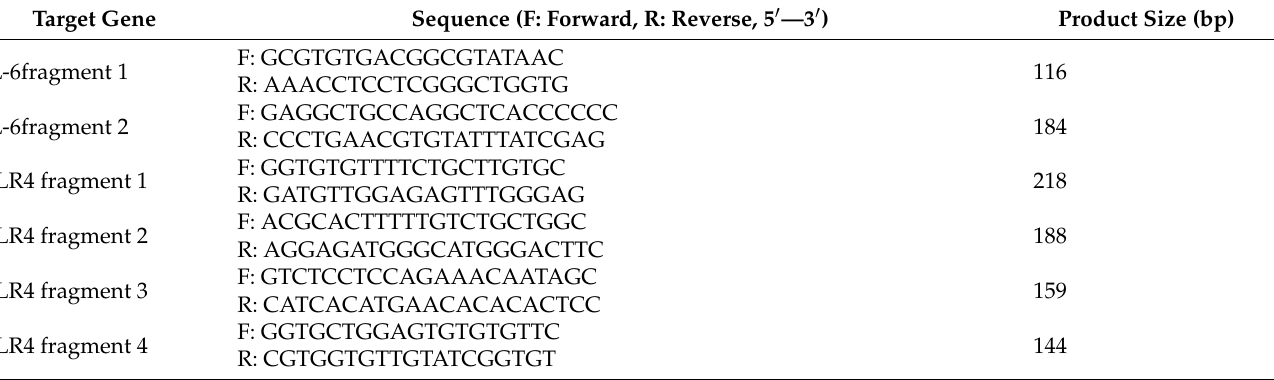
Table 2. Primer sequences used in